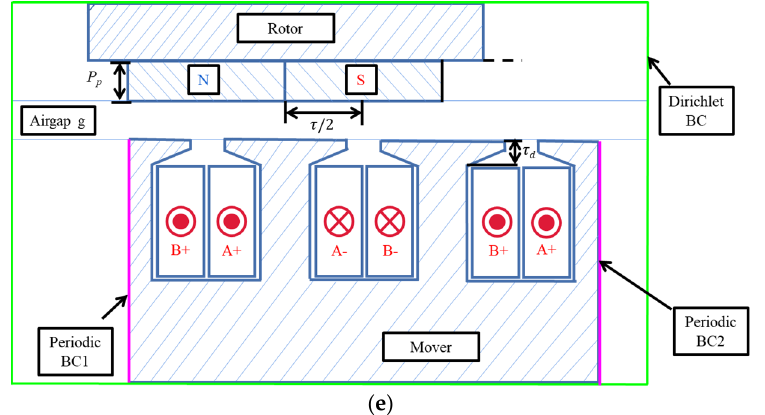
Figure 2. The topology structure of the proposed EMLS. ( a ) The 3D view of the proposed EMLS. ( b ) The side view of the proposed EMLS. ( c ) The helical-shaped winding. ( d ) The corresponding 2D model from main view of the 3D model when the thrust force is zero. ( e ) The 2D axially symmetric FEA model when the thrust force is maximum.